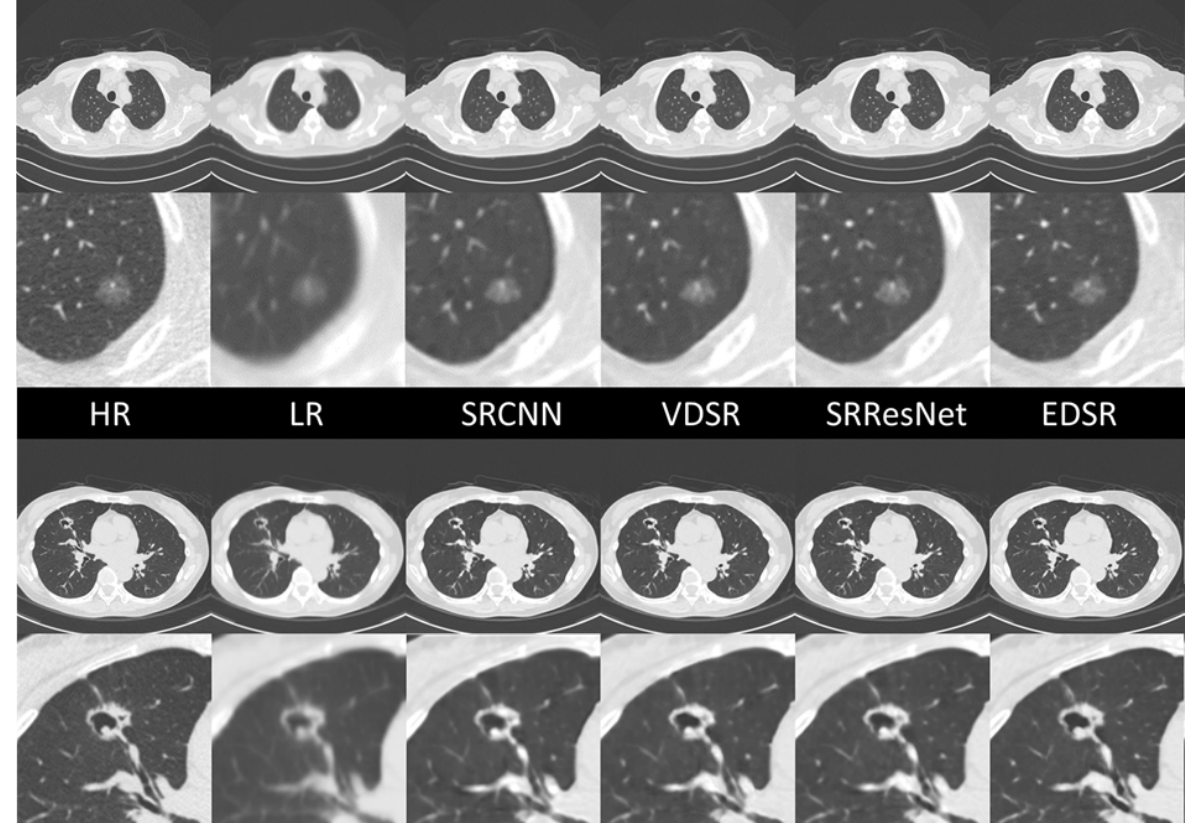
Figure 9. SR image samples of different AI models. All images were generated by applying SR models in the sagittal plan.